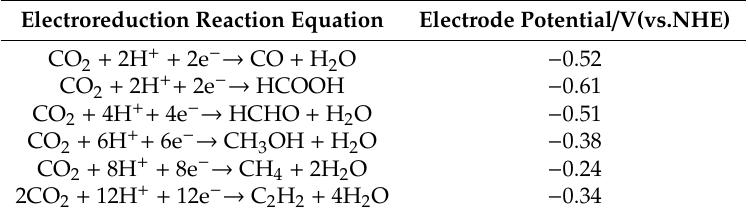
Table 3. CO 2 electrocatalytic reduction reaction and corresponding electrode potential.